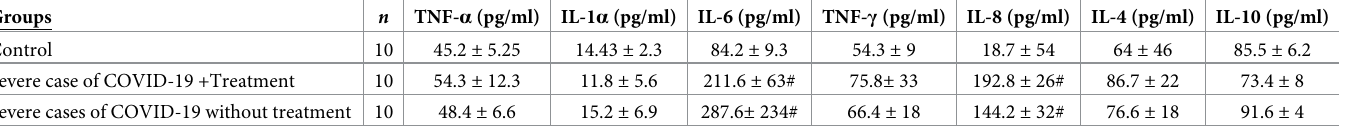
The data are means ± standard errors. P value < 0.05 for a comparison with the control